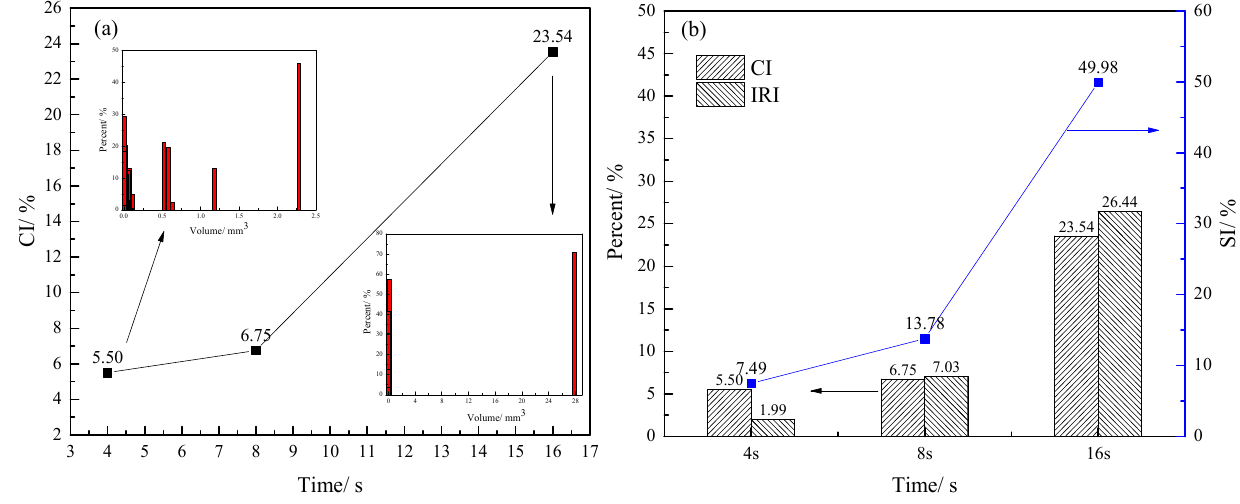
Figure 13. Characteristics Index of #1 iron ore at different times of smelting reduction. ( a ) CI results; ( b ) CI and IRI results.